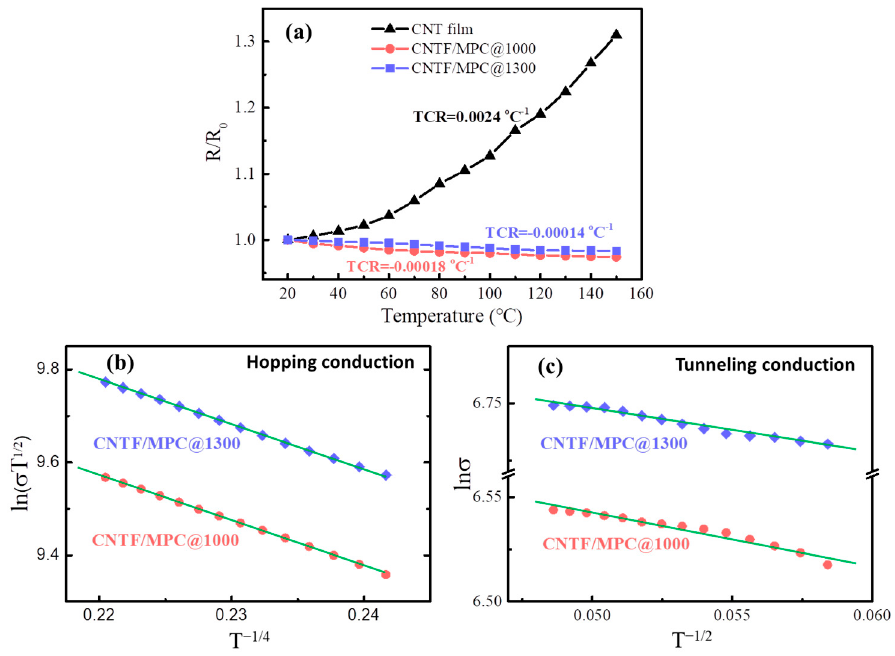
Figure 11. ( a ) Temperature dependence of resistance change in CNT film and CNTF/MPC nano- composites, ( b ) fitting line of variable range hopping conduction mechanism, and ( c ) tunneling conduction mechanism.